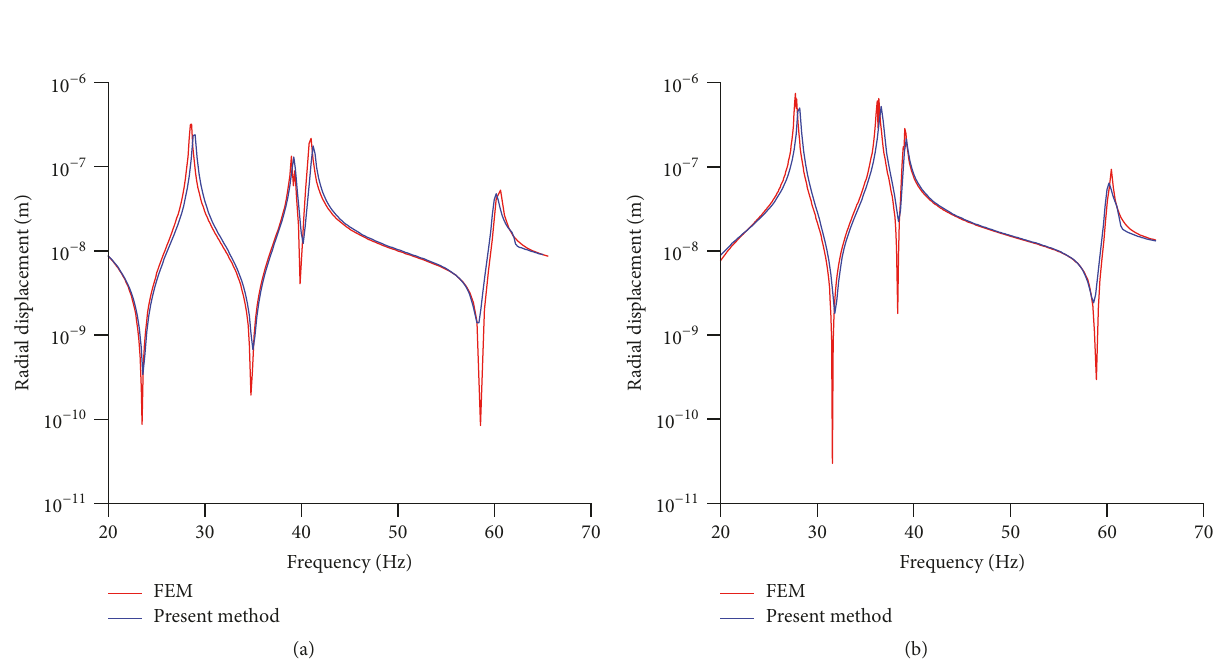
Figure 5: Some mode shapes of the ECE and PCE vessels.